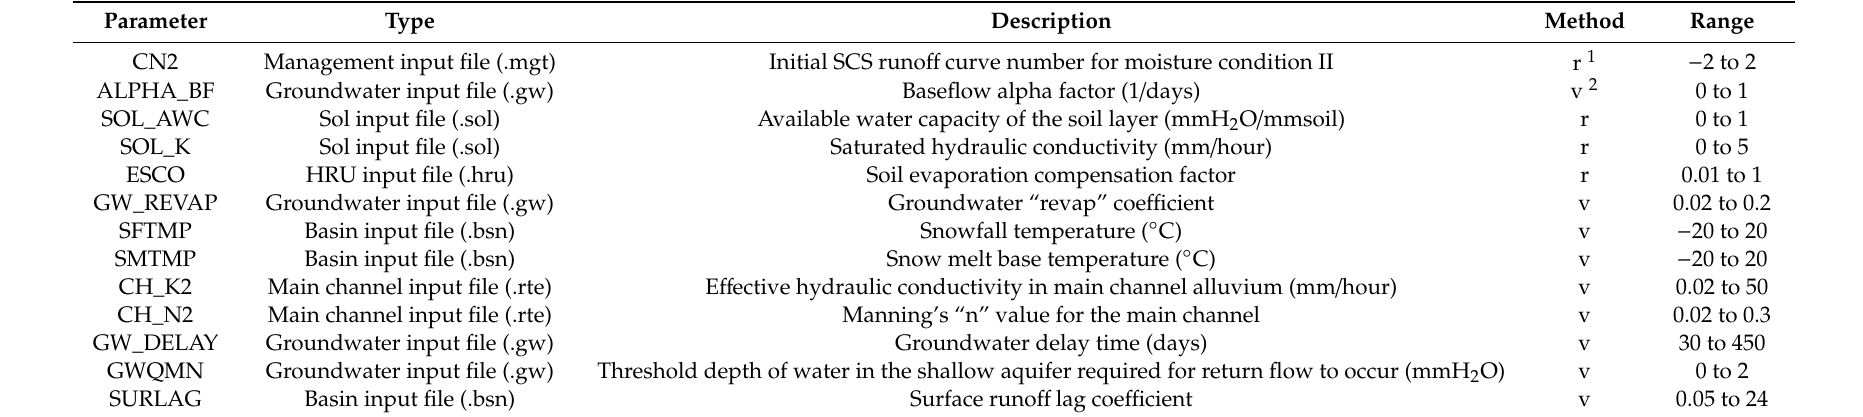
Table 2. The description and initial range of the SWAT model parameters used in this